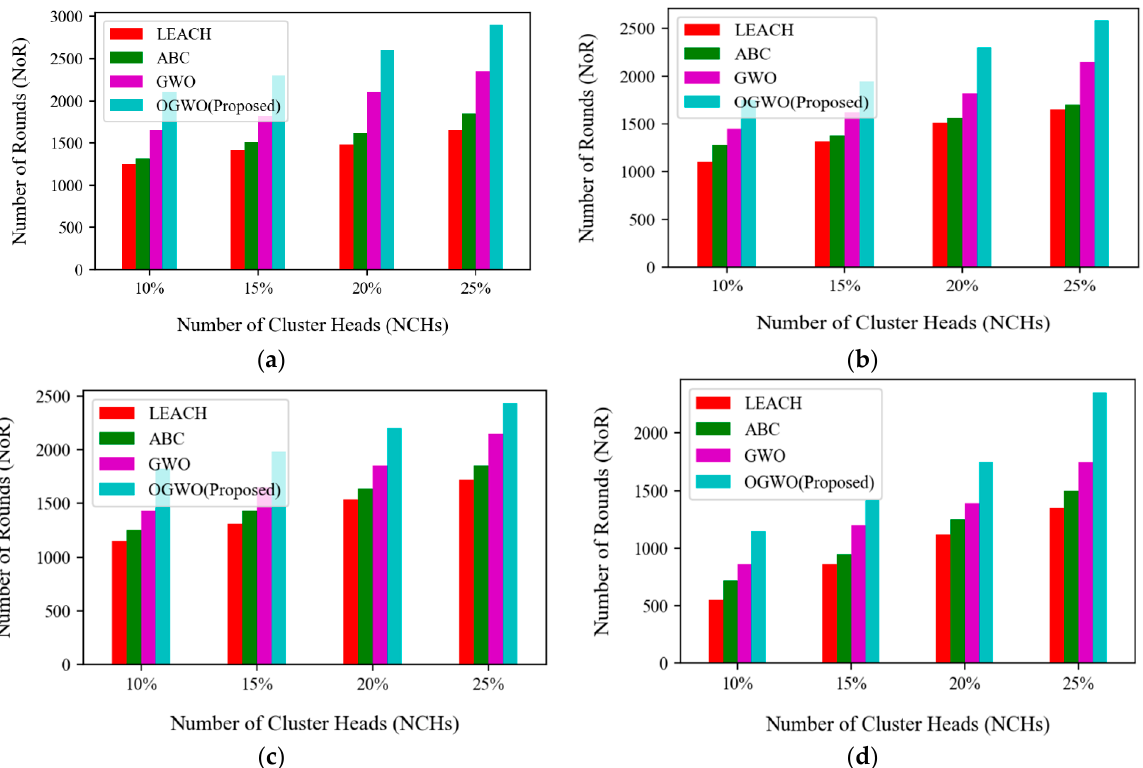
Figure 4. Comparison results of FND with respect to NoR by varying different CHs and NSNs ( a ) NSNs = 100, ( b ) NSNs = 200, ( c ) NSNs = 300, ( d ) NSNs = 400. ( a ) NSNs = 100, ( b ) NSNs = 200, ( c ) NSNs = 300, ( d ) NSNs =